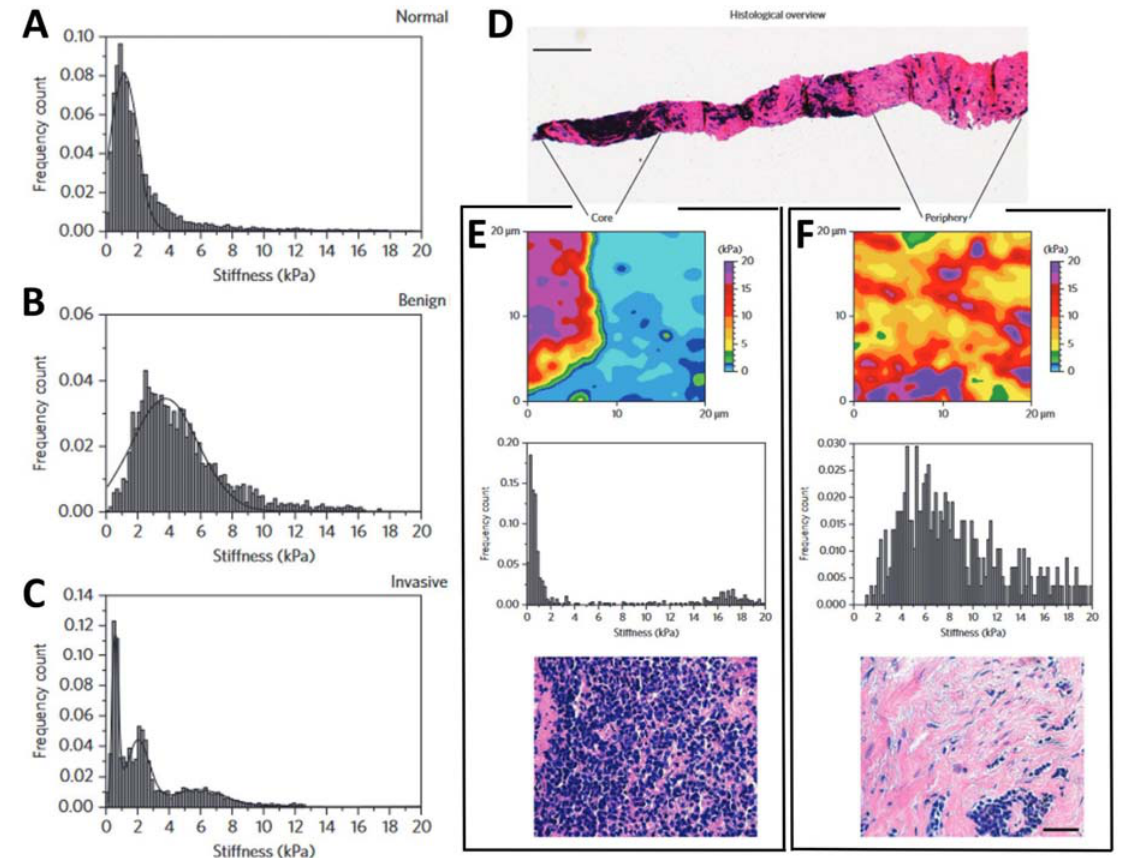
Figure 5. ( A ) The stiffness distribution for healthy mammary gland tissue was unimodal. ( B ) The analysis of the entire benign lesion revealed a unimodal but broader stiffness distribution. The stiffness increased compared with the healthy biopsy. ( C ) The stiffness distribution from a malignant tumor was multimodal. ( D ) The stiffness of cancer biopsies was different from the core to the periphery of the biopsies. Overview of the entire cancer biopsy with reference to the areas mapped in detail (scale bar, 500 μ m). ( E ) Top: representative AFM stiffness map 24 pixels × 24 pixels of the core region. Middle: the stiffness distribution exhibited pronounced softness within a narrow peak. Bottom: a dense population of cancer cells was located at the core region of the local histology. ( F ) Top: the stiffness map 24 pixels × 24 pixels at the periphery of the histological sample demonstrated stiff features. Middle: the stiffness distribution was broader and shifted towards higher values. Bottom: the periphery of the sample was mainly composed of fibrotic tissue. Scale bar, 50 μ m (also applies to the image in E, bottom). Reprinted with permission from Ref. [95]. 2012, Nat. Nanotechnol.